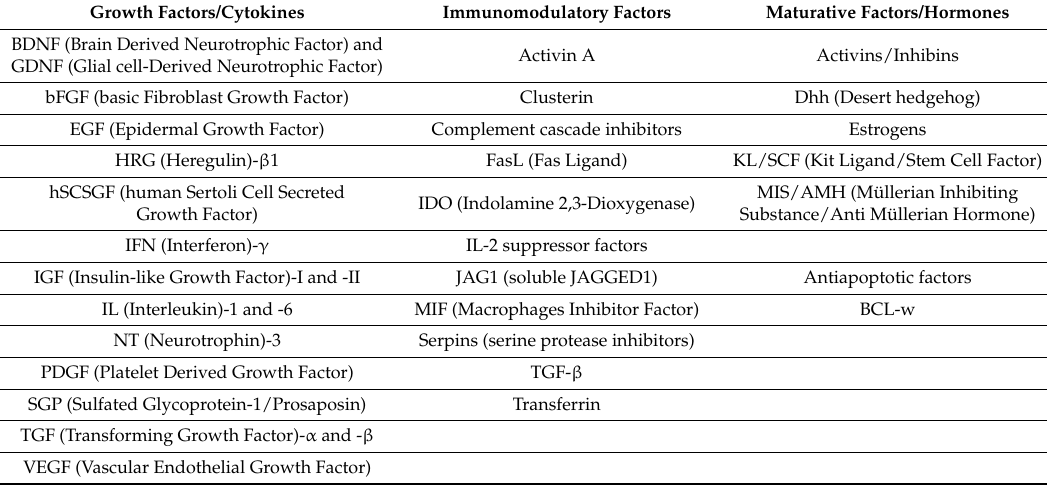
Table 2. List of the major factors secreted by